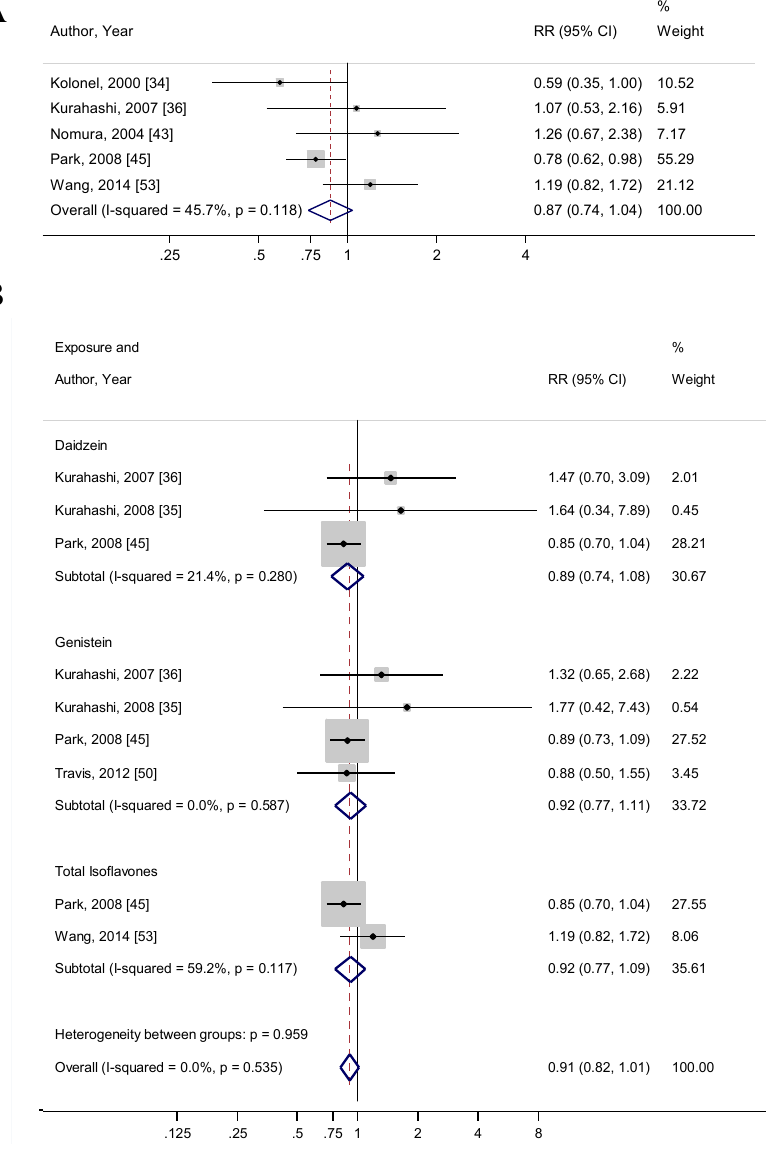
Figure 4. Forest plots for ( A ) total soy intake and risk of advanced prostate cancer; and ( B ) isoflavone exposure and risk of advanced prostate cancer. These associations were indicated as a relative risk (RR) estimate with the corresponding 95% confidence interval (CI).